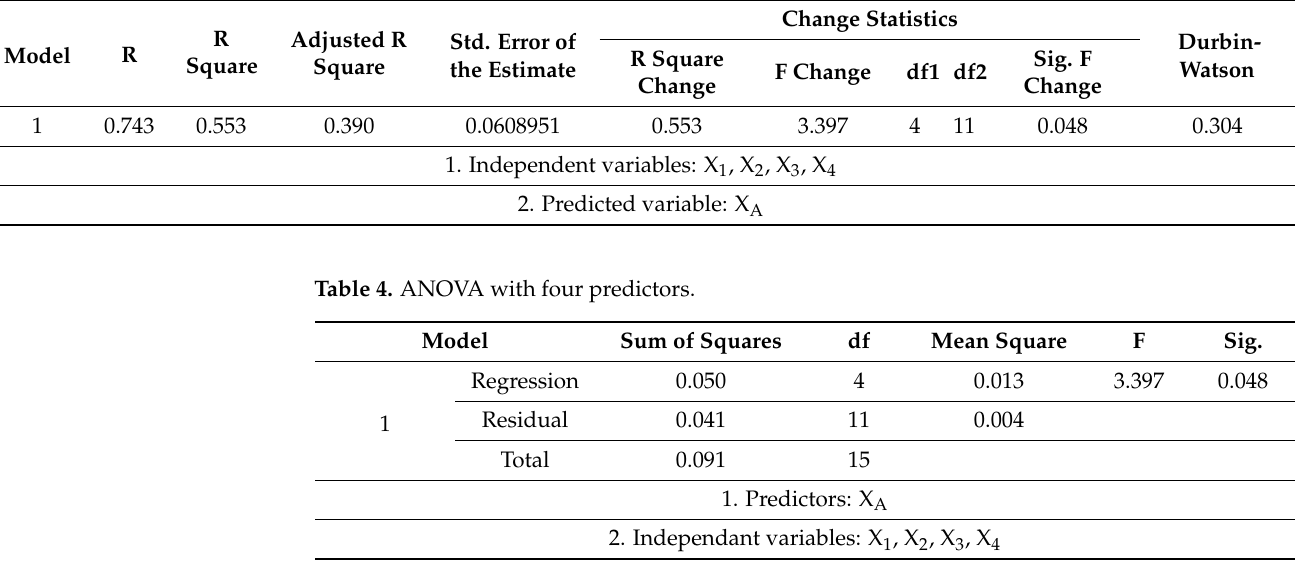
Table 3. Summary of developed model with four predictors.